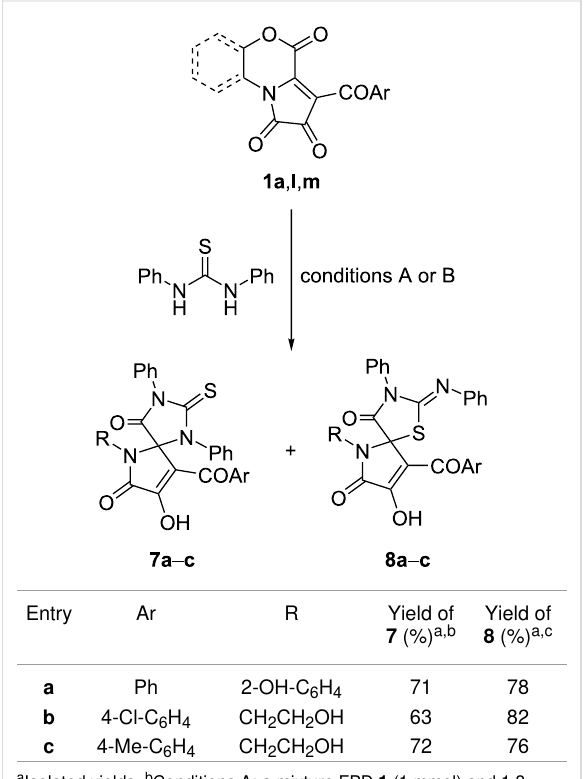
Table 6: Reaction of FPDs 1 with